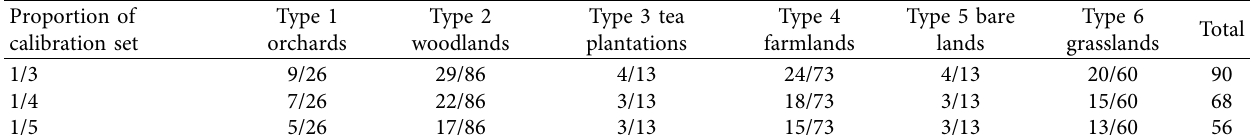
Table 8: The calibration set samples in different proportions by random method.